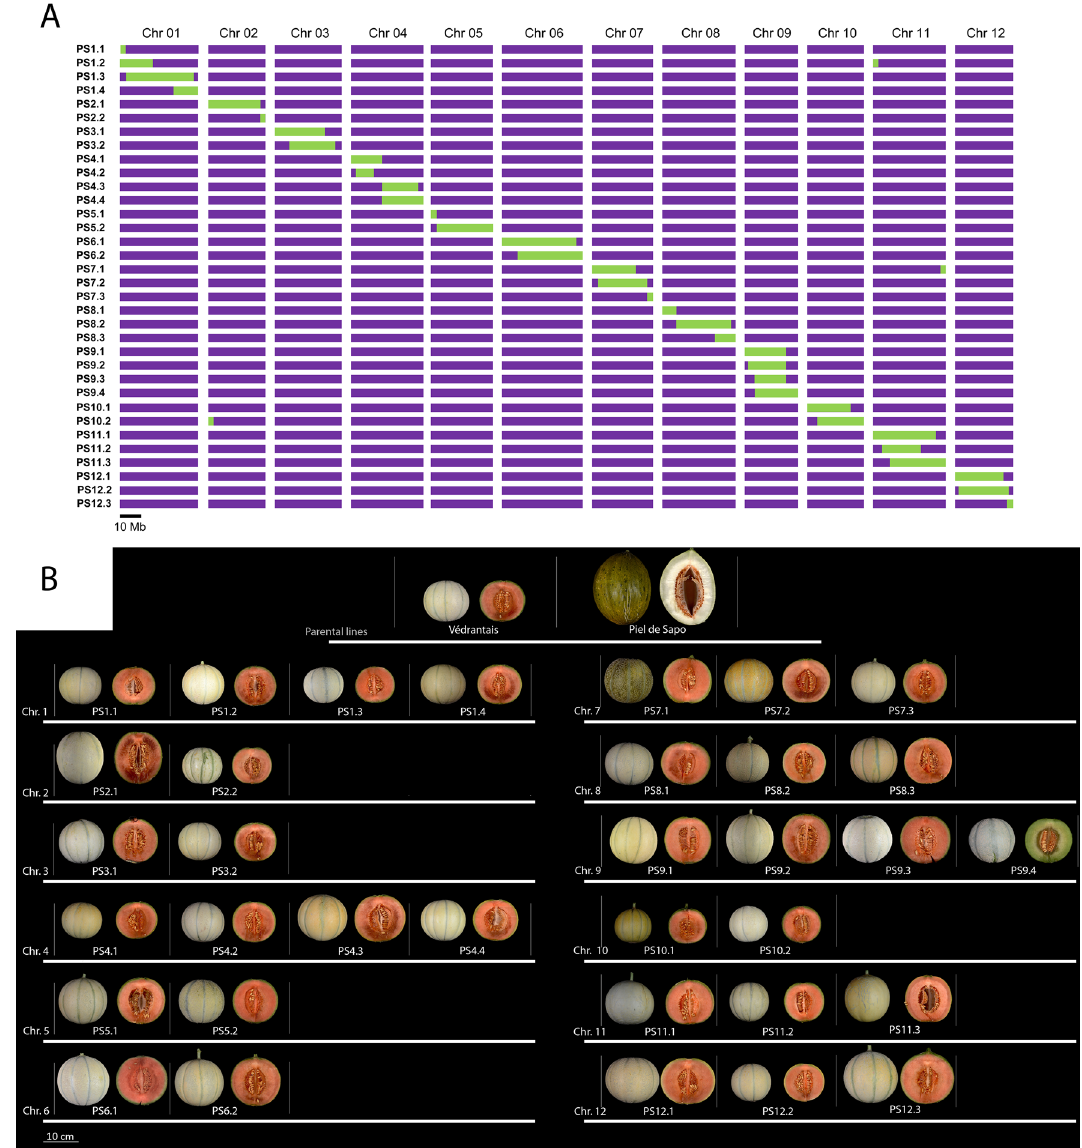
Figure 2. The IL collection. ( A ) Genotypic characterization of the IL collection. Purple represents the genotype of the recurrent parent Ved and green, the genotype of the donor parent PS. ( B ) Representative images of the